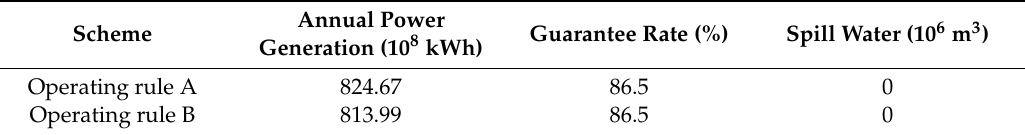
Table 3. Operation results of operating rules A and B (the operating horizon is 11 June 2001 to 11 June 2002).